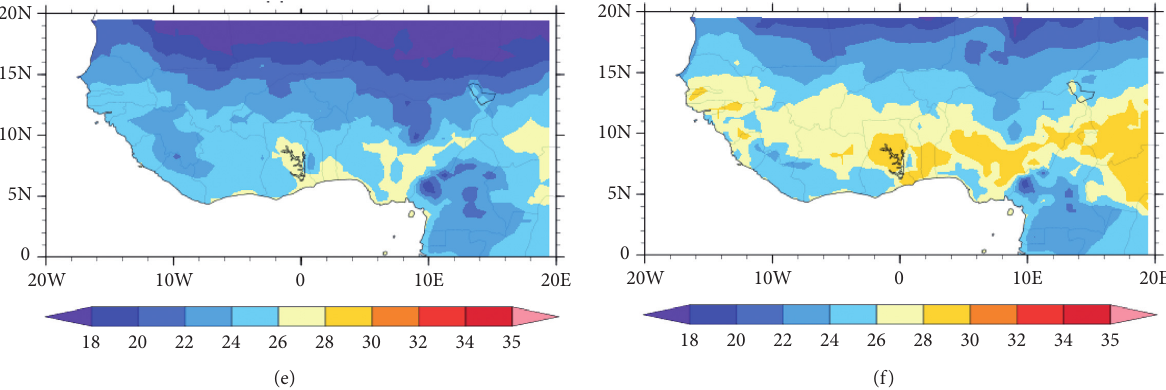
Figure 4: Spatial distribution of average 2m surface temperature ( ° C) for Dec 16 th 2011–Feb 28 th , 2012. (a) Era-interim. (b) FNL. (c) Noah-